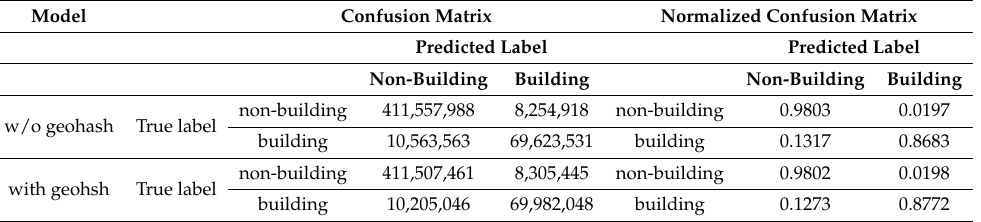
Table 8. Confusion matrices of models with and without geohash codes trained on the Inria dataset. Normalized confusion matrix normalizes the elements in each